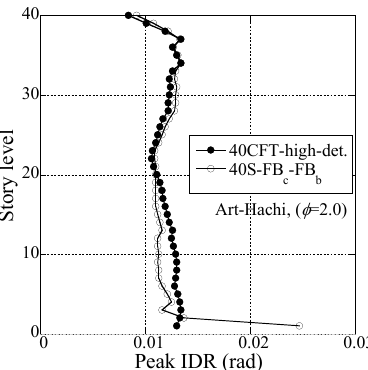
Figure 13. Distribution of maximum story drift angle of high ‐ rise SMRF and CFST ‐ MRF (moment resisting frame) models.